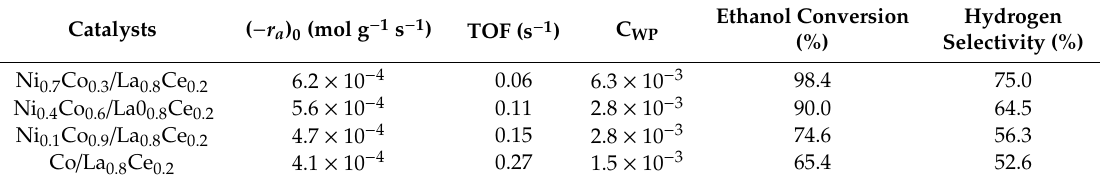
Table 2. Initial rate of reaction, turnover frequency (TOF), Weisz–Prater criterion, conversion, and hydrogen selectivity for ethanol decomposition. Reaction conditions: total flow, 100 mL min − 1